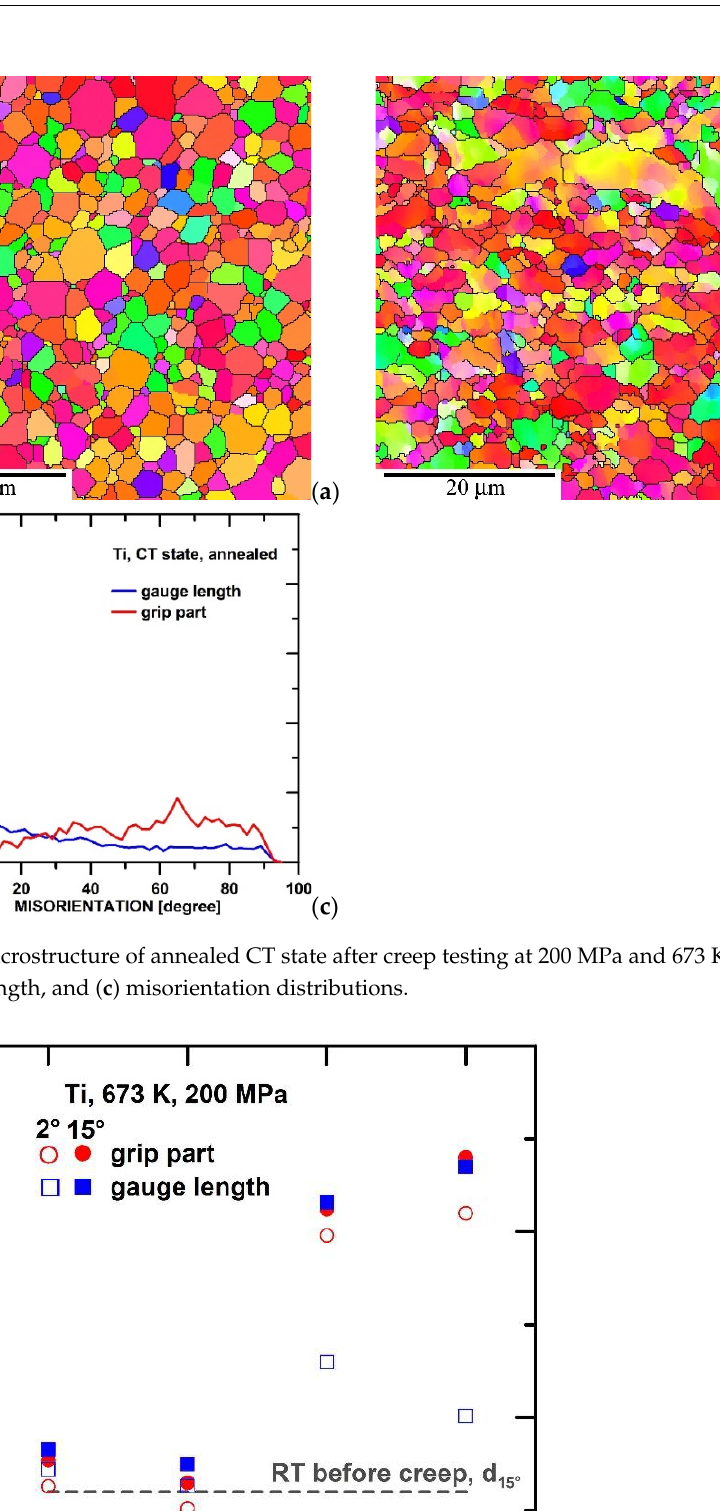
Figure 8. Comparison of grain and subgrain sizes in the grip parts and gauge lengths of CT and RT states tested at 673 K and 200 MPa.